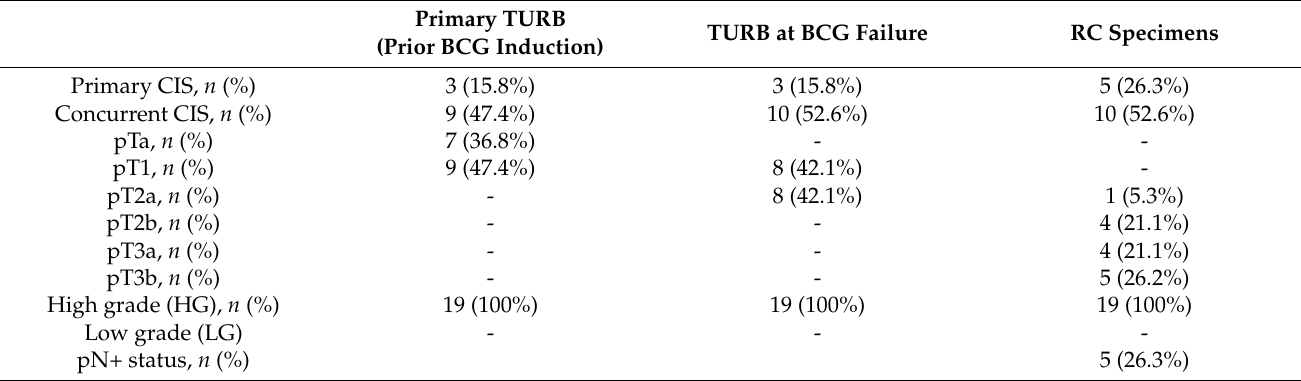
Table 2. Overview of histopathological features concerning primary transurethral resection of the bladder (TURB) (prior Bacillus Calmette Gu é rin (BCG) induction), TURB at BCG failure, and finally, histopathology in RC specimens.